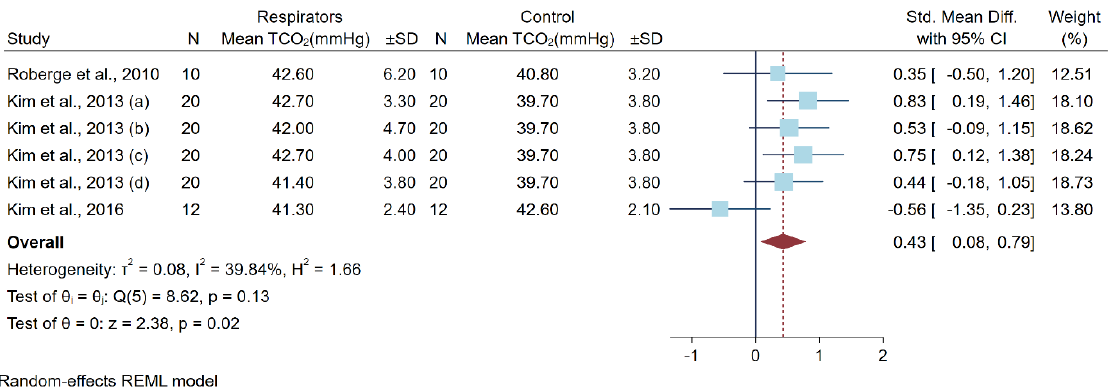
Figure 5. Differences in Carbon Dioxide Levels after a Low-to-Moderate Physical Workload. Abbreviations: CI, confidence interval; TCO 2 , transcutaneous carbon dioxide level; SD, standard deviation; std. mean diff., standard mean difference [14,15,18].